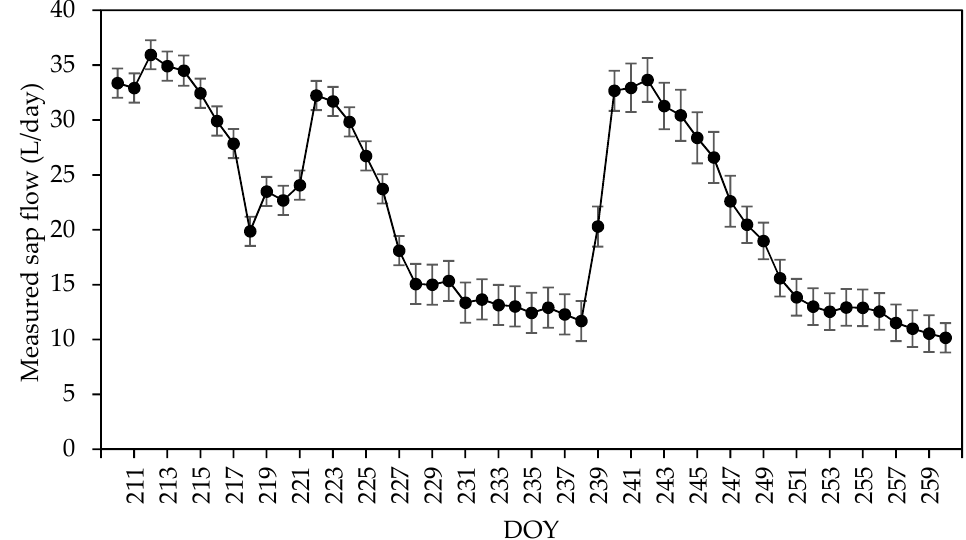
Figure 9. Measured sap flow during the experimental period. Each value shown is the average of eight sets of probes (four sets of probes per tree). The statistical standard error is shown in bars.